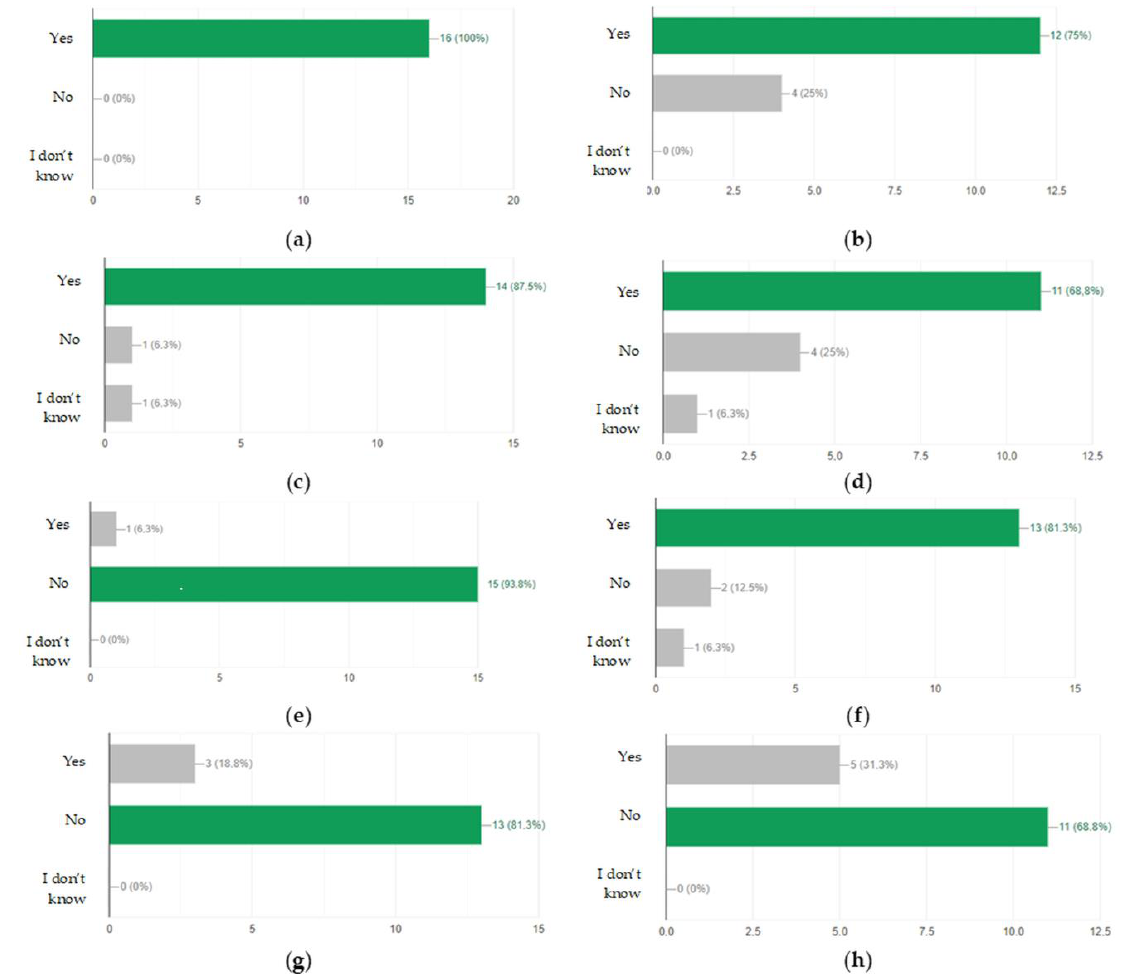
Figure 5. Statistics of results concerning the answers to the questions asked on the selected day of the training: ( a ) Does the place of the warning board display matter? ( b ) Can uncontrolled movement of the belt occur after the power is turned off? ( c ) Should the drive frame be anchored before installing the drums and before positioning the belt? ( d ) Is the positioning of the belt only carried out with the belt take-up unit carriage? ( e ) Can I use a conveyor with a broken emergency cable? ( f ) Could an oil level that is too low contribute to a fire? ( g ) Is the most important thing to do in the event of a fire to notify a supervisor? ( h ) Can machine assemblies be transported by